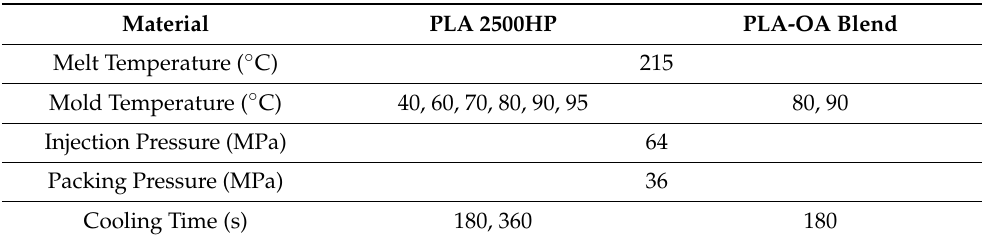
Table 1. Processing Parameters for PLA Injection